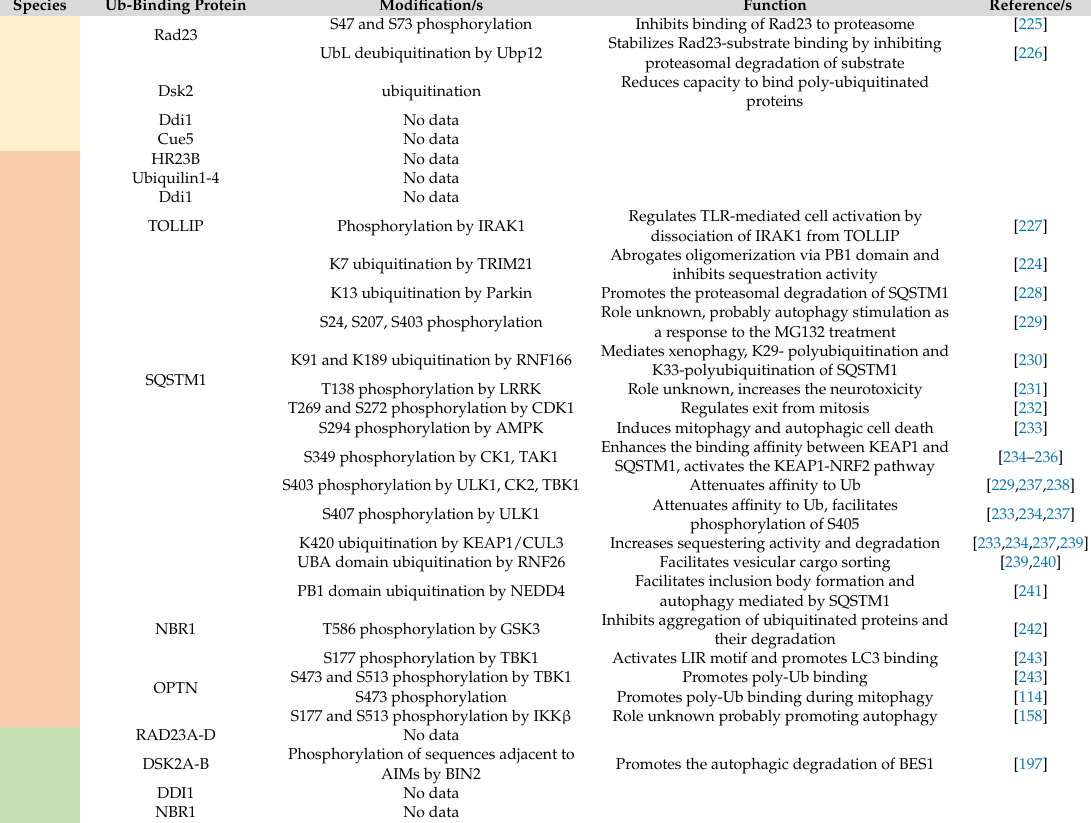
Table 1. Ub-binding receptors involved in protein quality control (PQC)